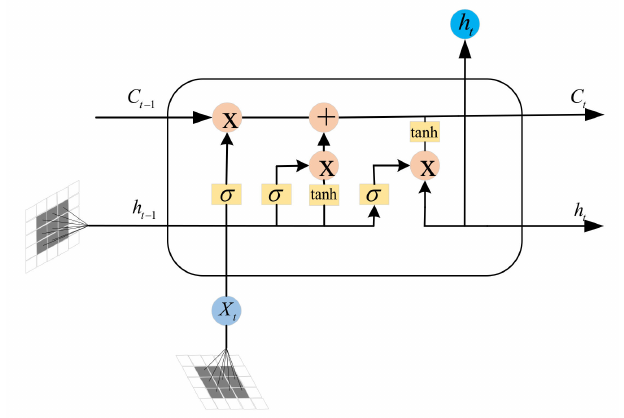
Figure 2. ConvLSTM